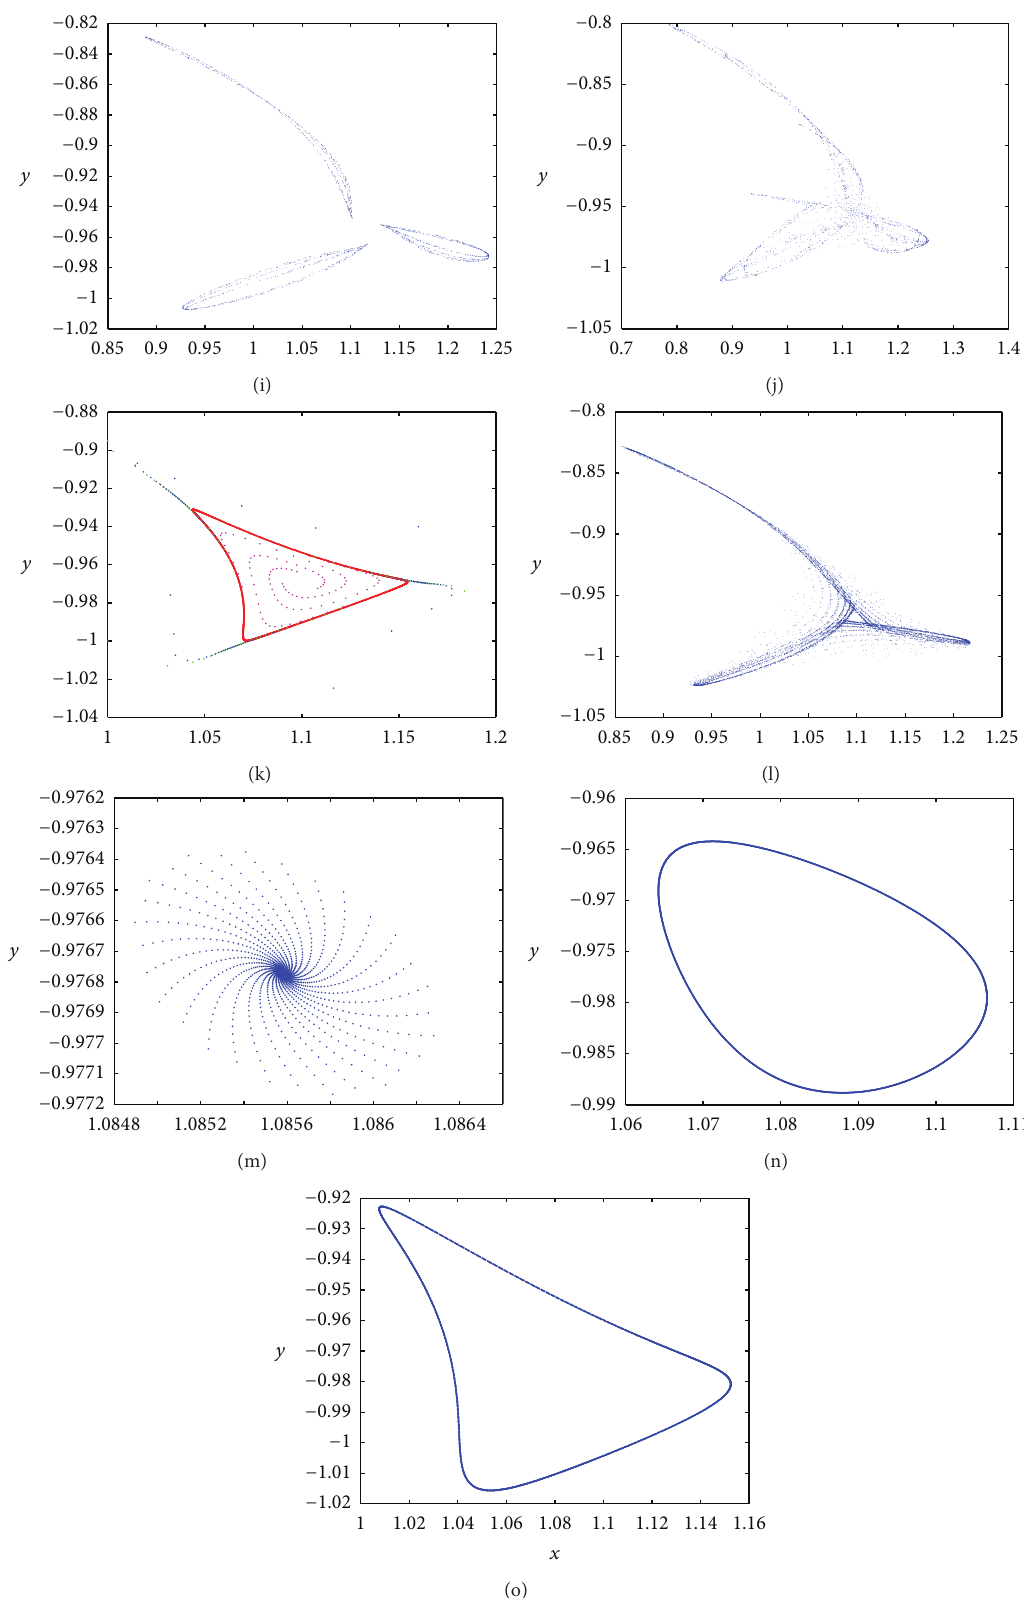
Figure 3: Phase portraits corresponding to Figure 1 for different 𝛿 and 𝑑 . (a) 𝛿 = 1.6771238 , 𝑑 = 0.13 ; (b) 𝛿 = 1.6771238 , 𝑑 = 0.125 ; (c) 𝛿 = 1.6771238 , 𝑑 = 0.12457 ; (d) 𝛿 = 1.6771238 , 𝑑 = 0.12 ; (e) 𝛿 = 1.6771238 , 𝑑 = 0.115 ; (f) 𝛿 = 1.6771238 , 𝑑 = 0.1134 ; (g) 𝛿 = 1.6771238 , 𝑑 = 0.09 ; (h) 𝛿 = 1.685 , 𝑑 = 0.12428002 ; (i) 𝛿 = 1.78 , 𝑑 = 0.12428002 ; (j) 𝛿 = 1.83 , 𝑑 = 0.12428002 ; (k) 𝛿 = 1.75 , 𝑑 = 0.14 ; (l) 𝛿 = 1.9 , 𝑑 = 0.14 ; (m) 𝛿 = 1.76 , 𝑑 = 0.15 ; (n) 𝛿 = 1.77 , 𝑑 = 0.15 ; (o) 𝛿 = 1.83 , 𝑑 = 0.15